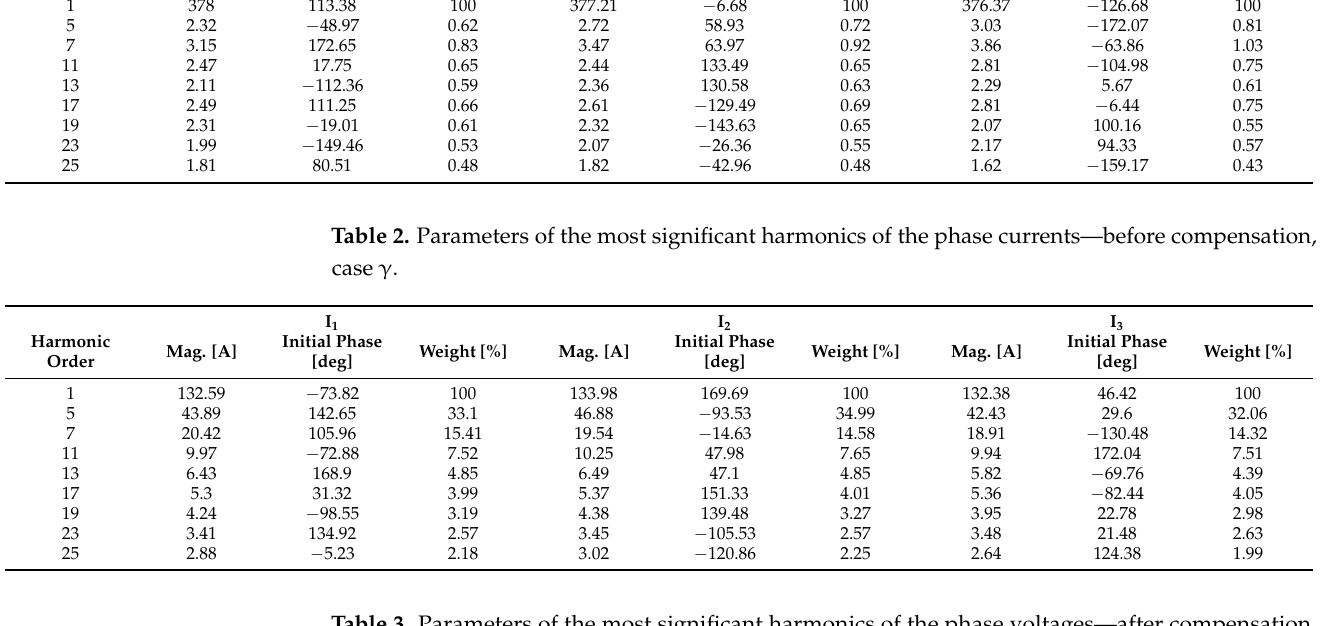
Table 3. Parameters of the most significant harmonics of the phase voltages—after compensation, case γ